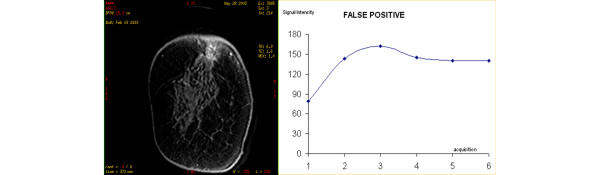
Magnetic resonance mammography 15 months after surgery. The postcontrast image (left image) and the signal–intensity curve (right image) show a 2 cm lesion with inhomogeneous enhancement. (Breast Imaging Reporting and Data System IV). Histology and follow-up reported no malignancy.